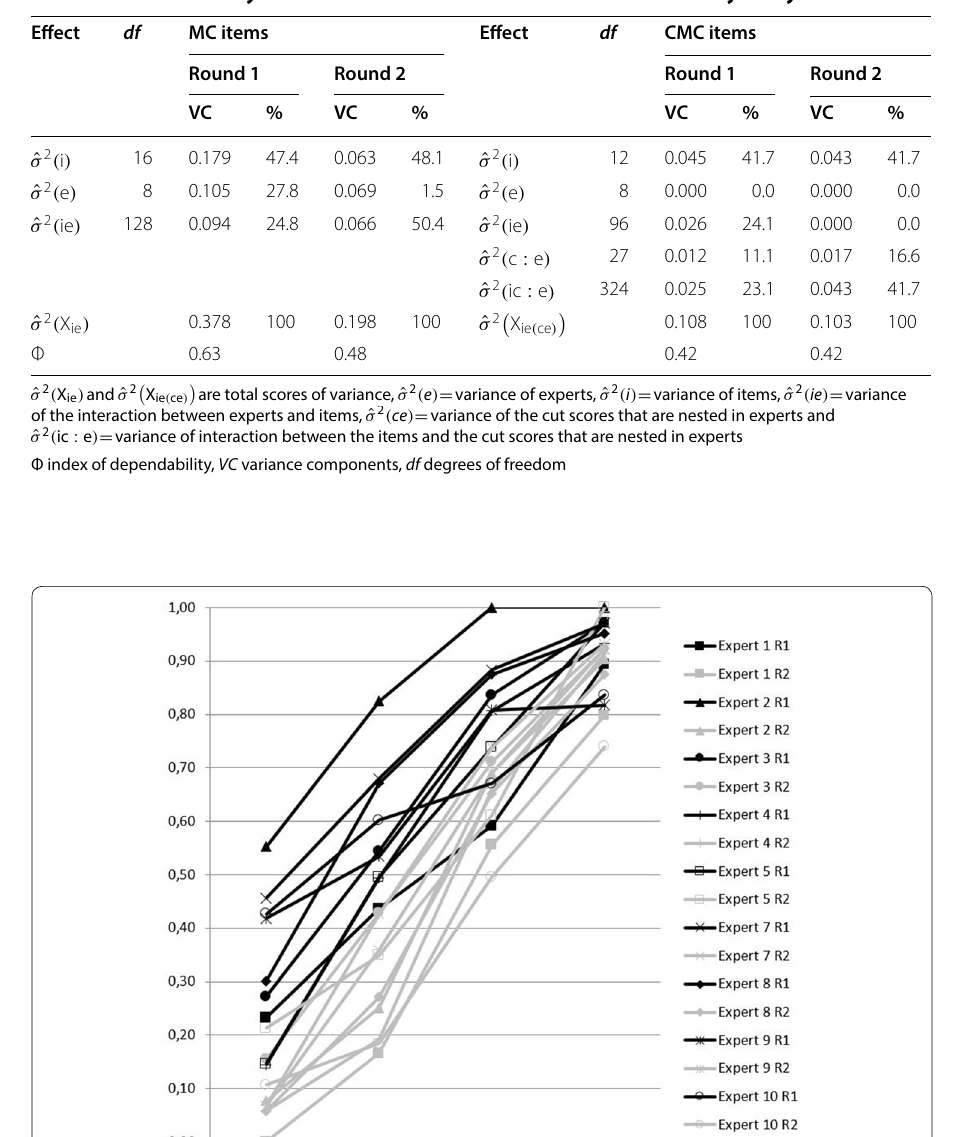
Table 4 Science ability cut score VCs and G coefficients of the reliability analyses